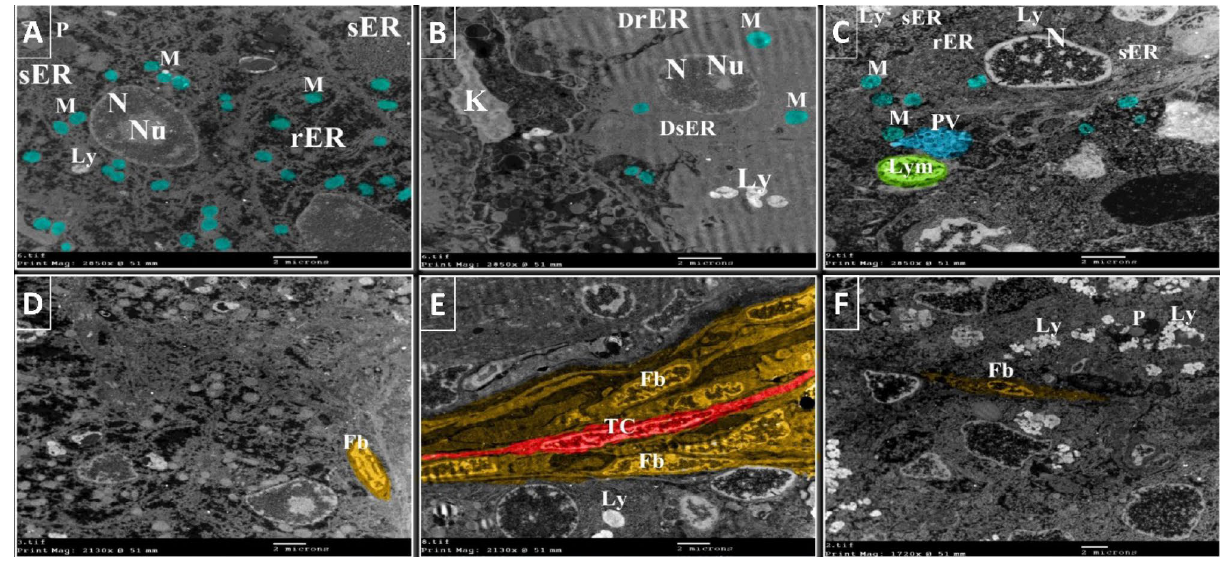
Figure 8. Negative images of the photomicrographs shown in Fig.